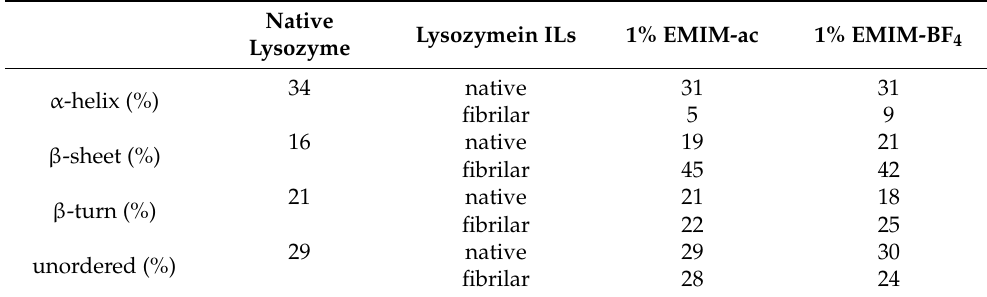
Table 3. Secondary structure content estimated from CD spectra measured for 1% ILs concentration at the end of the incubation period. Open software Dichroweb was used for deconvolution of